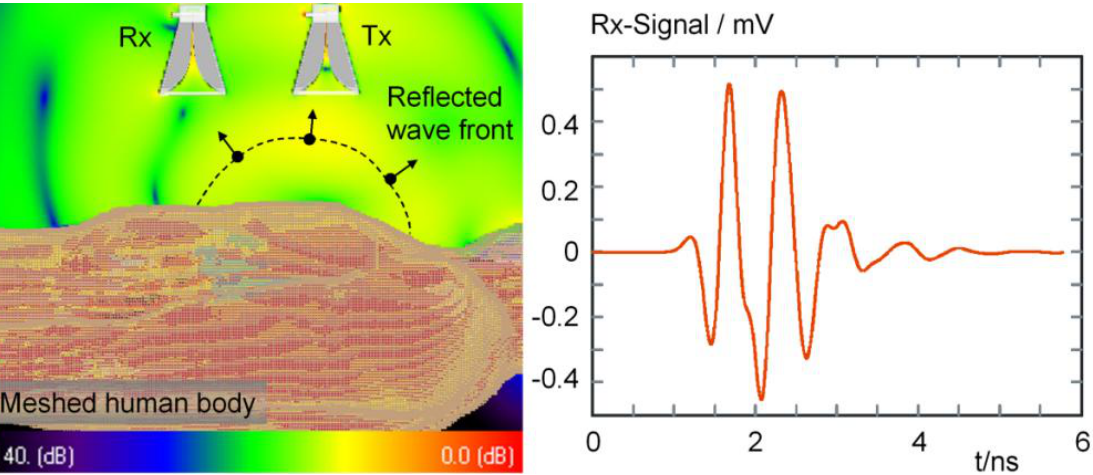
Figure 15. Left : Simulated wave propagation with reflected wave front. Right : Simulated output signal of the receiving antenna after excitation with a Gaussian